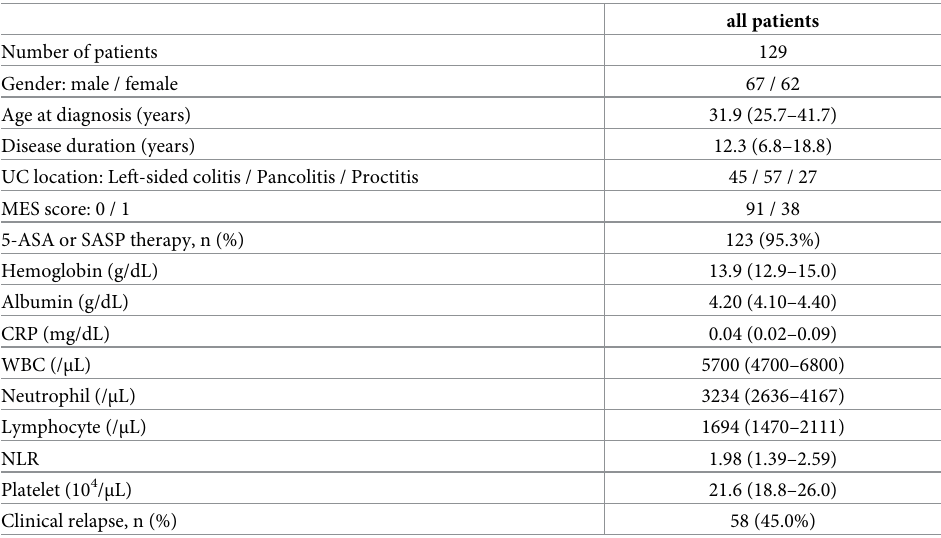
Table 1. Baseline characteristics of the study population.